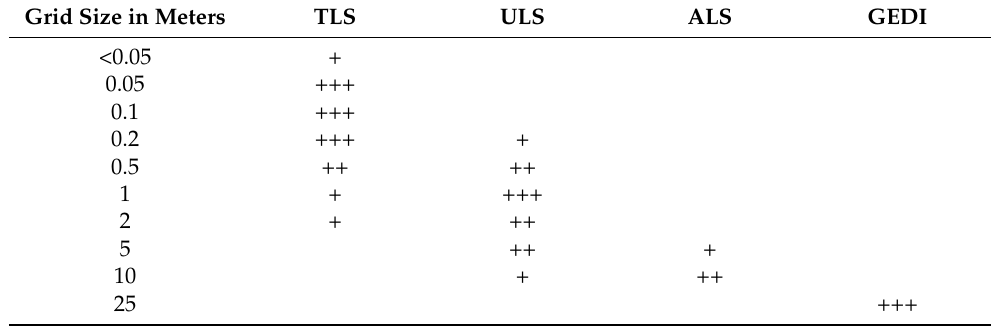
Table 2. Overview of grid sizes for different lidar platforms. + indicate the suitability of the grid size for the